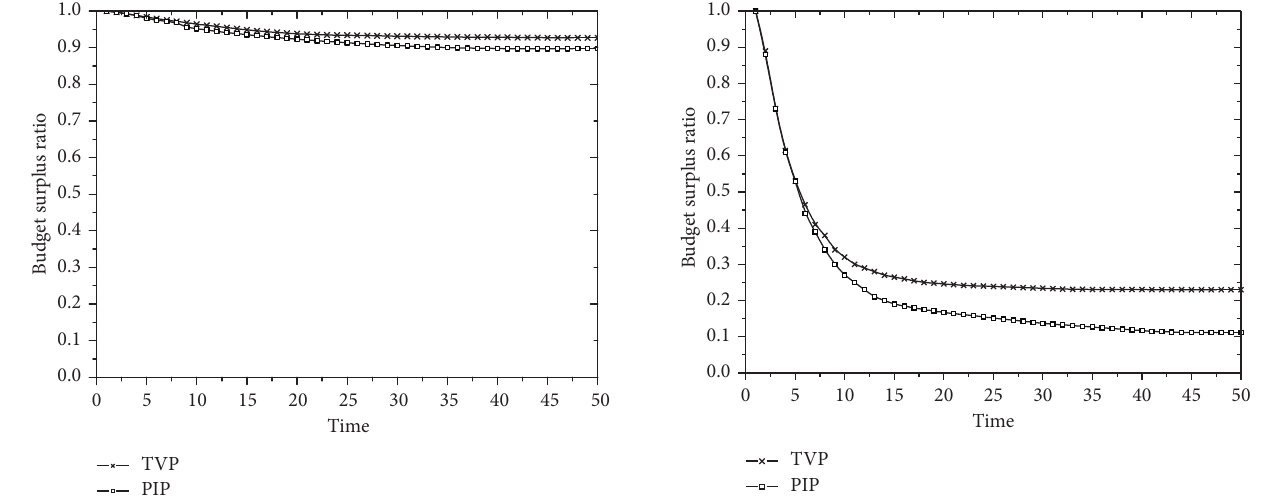
Figure 7: Task type where utility is directly proportional to task progress.